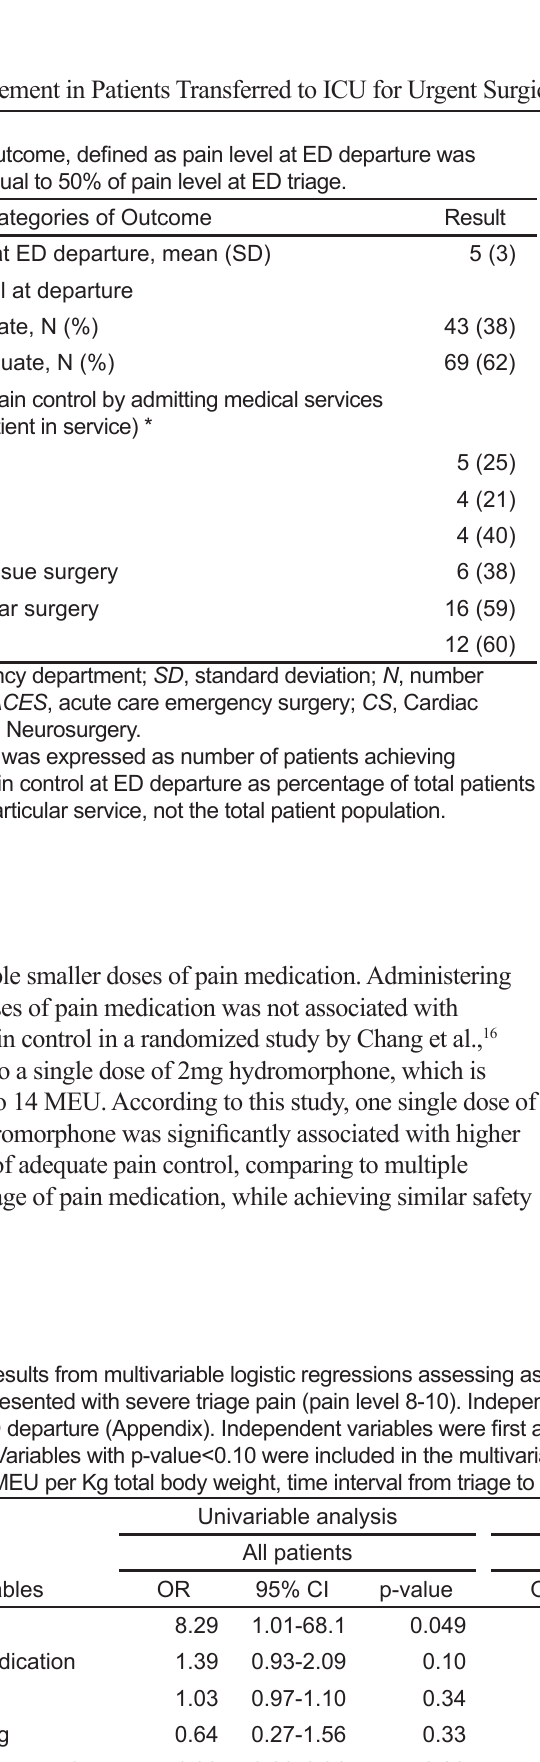
CI , confidence interval; OR , odds ratio; ESI , Emergency Severity Index; MEU , morphine equivalent unit; kg ,